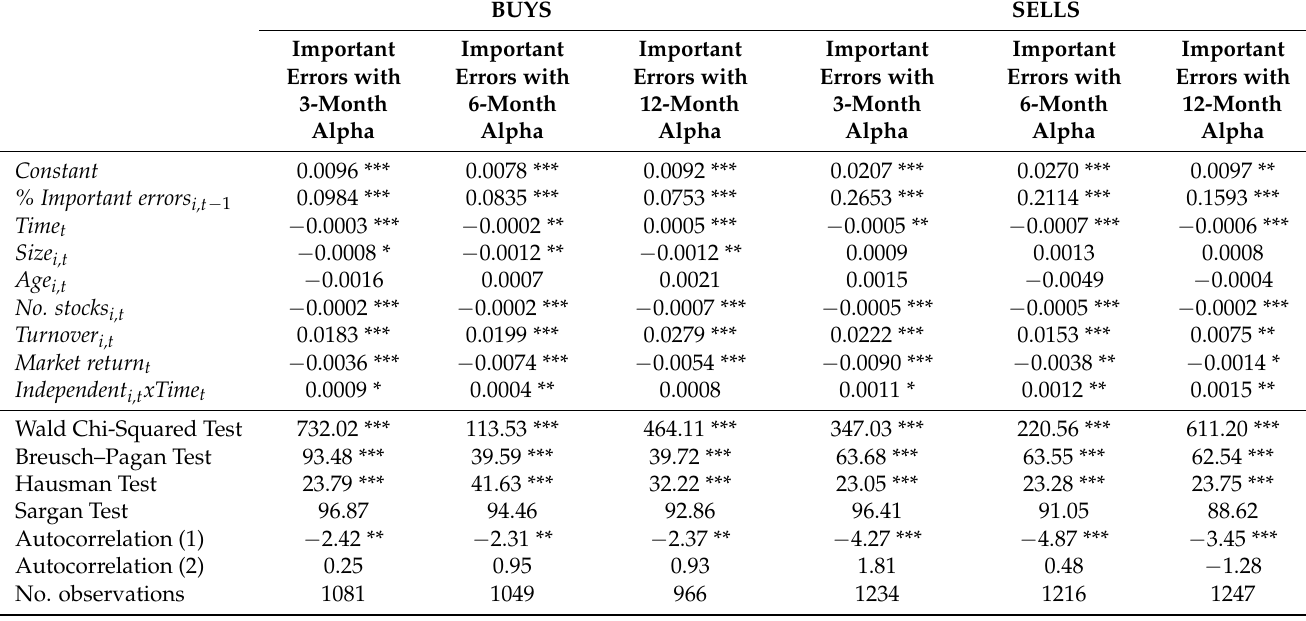
Table 8. Learning results by independence of fund family from financial service groups